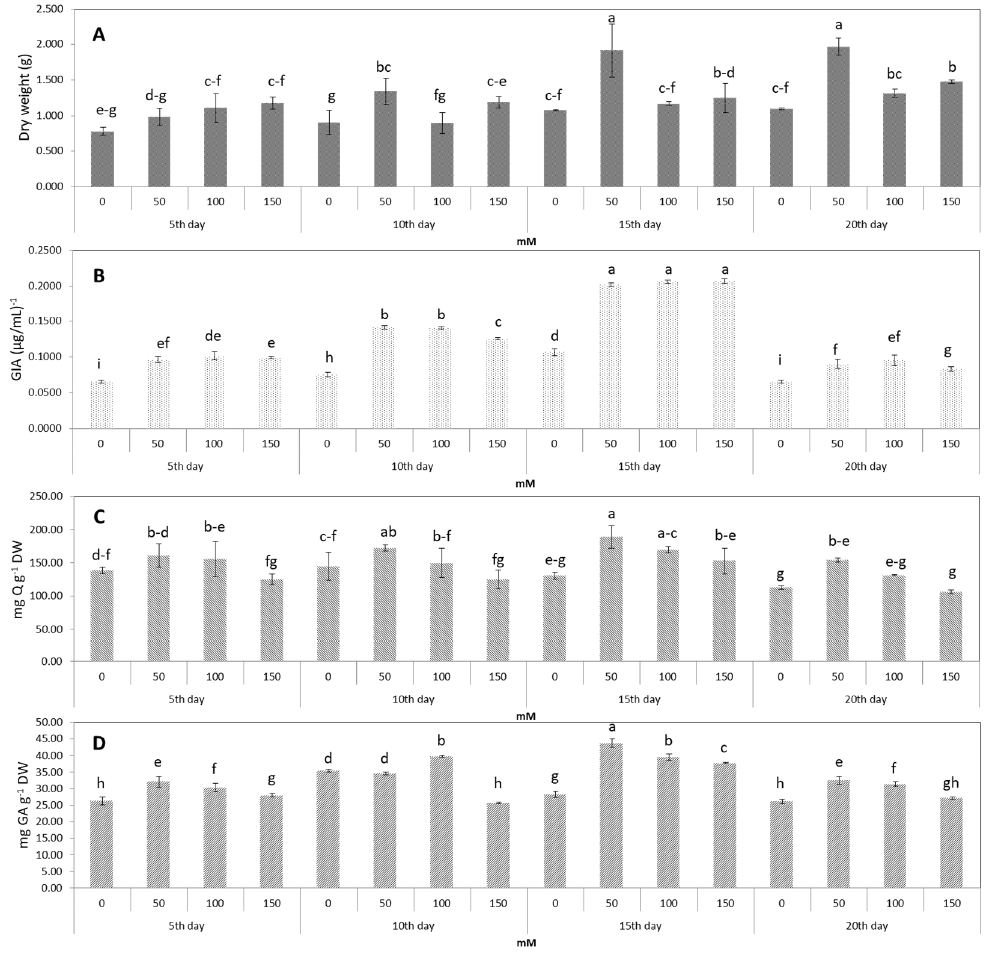
Figure 6. Effect of the CTS and exposure time (ET) on AHRs. ( A ) DW, ( B ) GIA, ( C ) FLA ( D ) PHEL. Error bars represent standard deviations. The values in one line marked with different lower-case letters denote significant differences between samples at p < 0.05 (Duncan’s multiple range test).